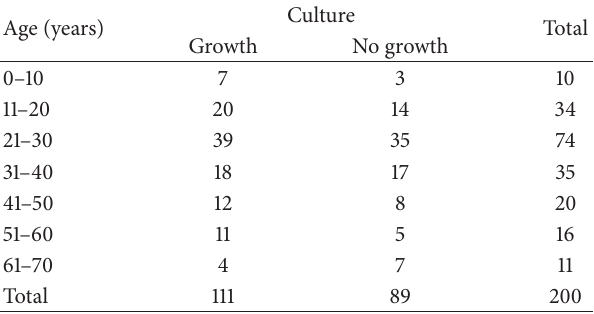
Table 4: Pattern of fungal growth according to age